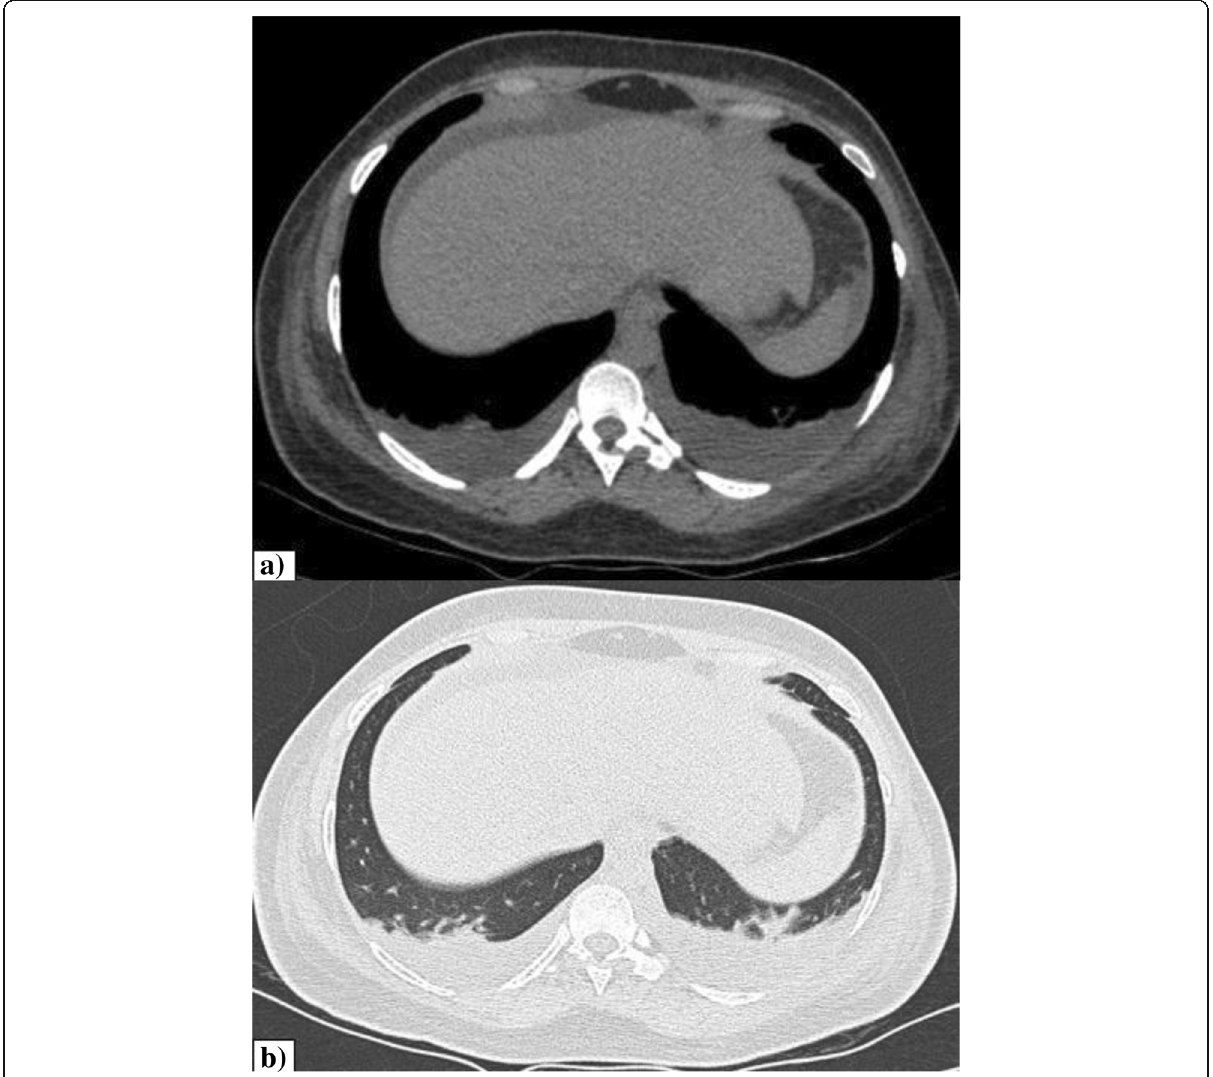
Fig. 2 Pleural effusion. a , b Axial CT thorax (mediastinal window and lung window) of a 38-year-old COVID pneumonia patient showing bilateral pleural effusion with underlying sub-segmental